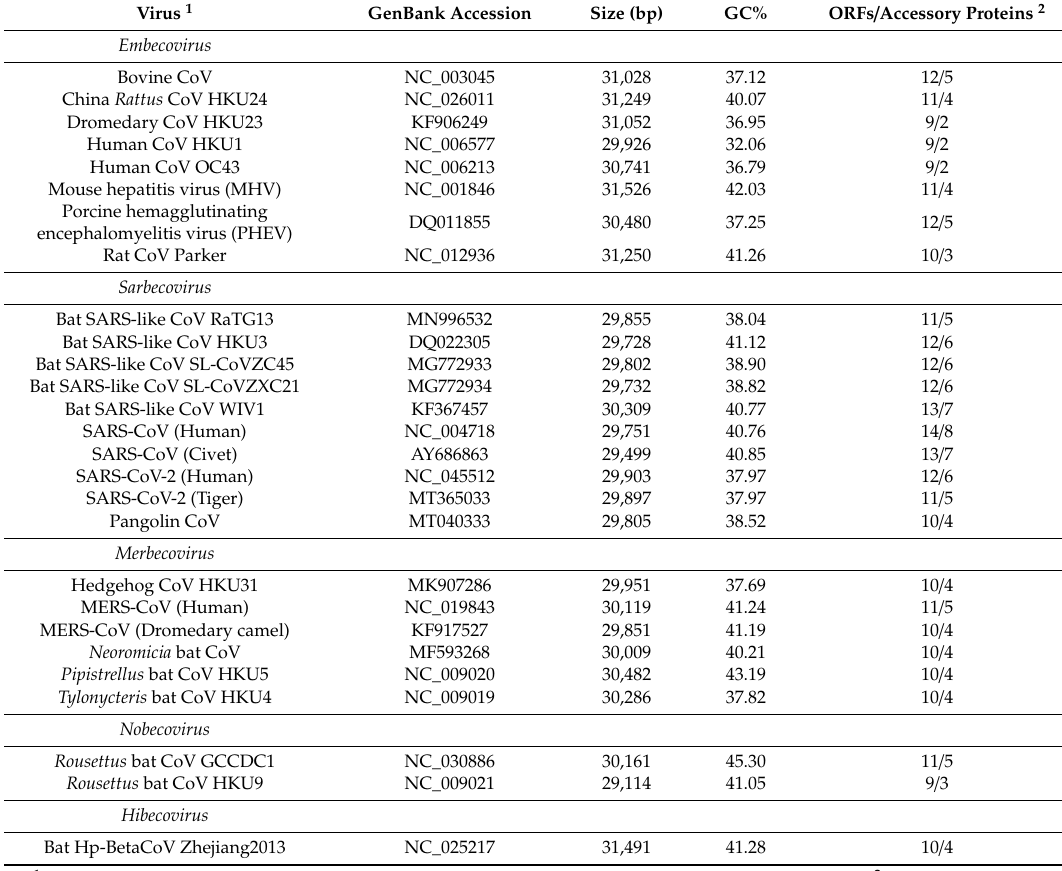
Table 1. Genomic features of representative